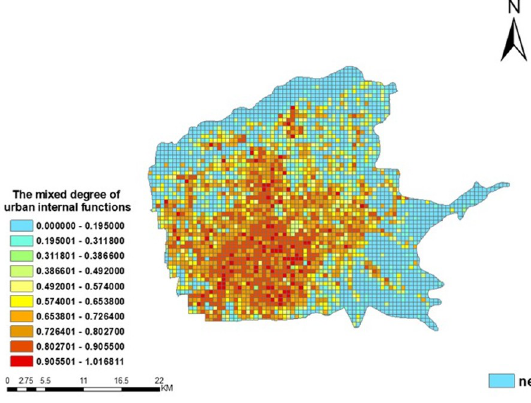
Fig 8. The mixed degree of functions in the main urban area of